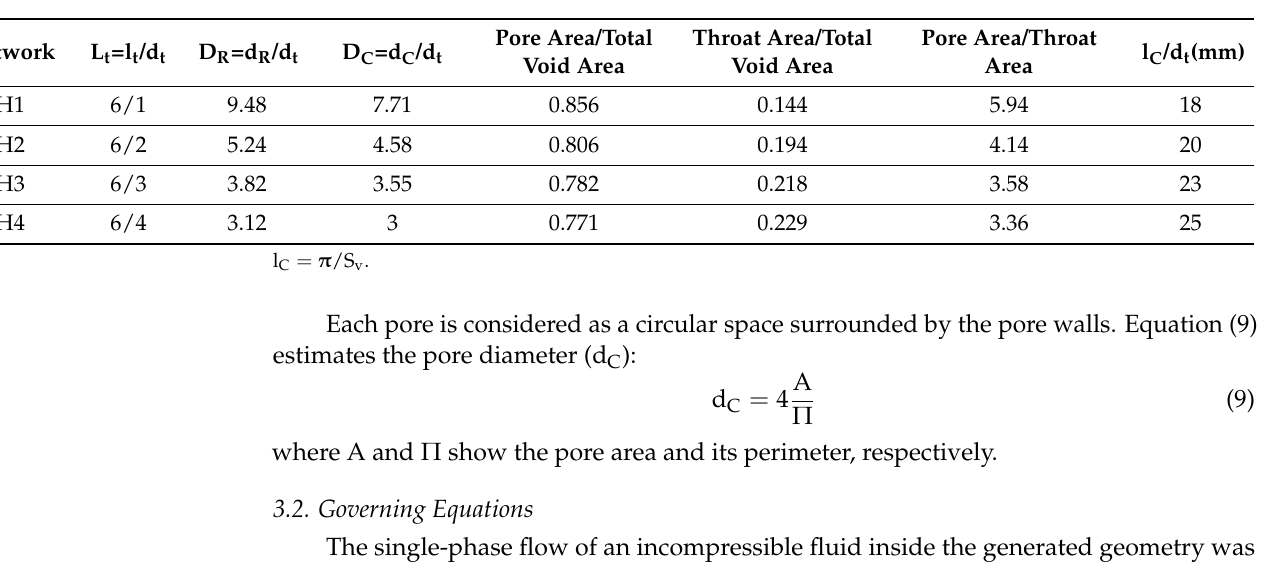
Table 1. Geometrical parameters of the